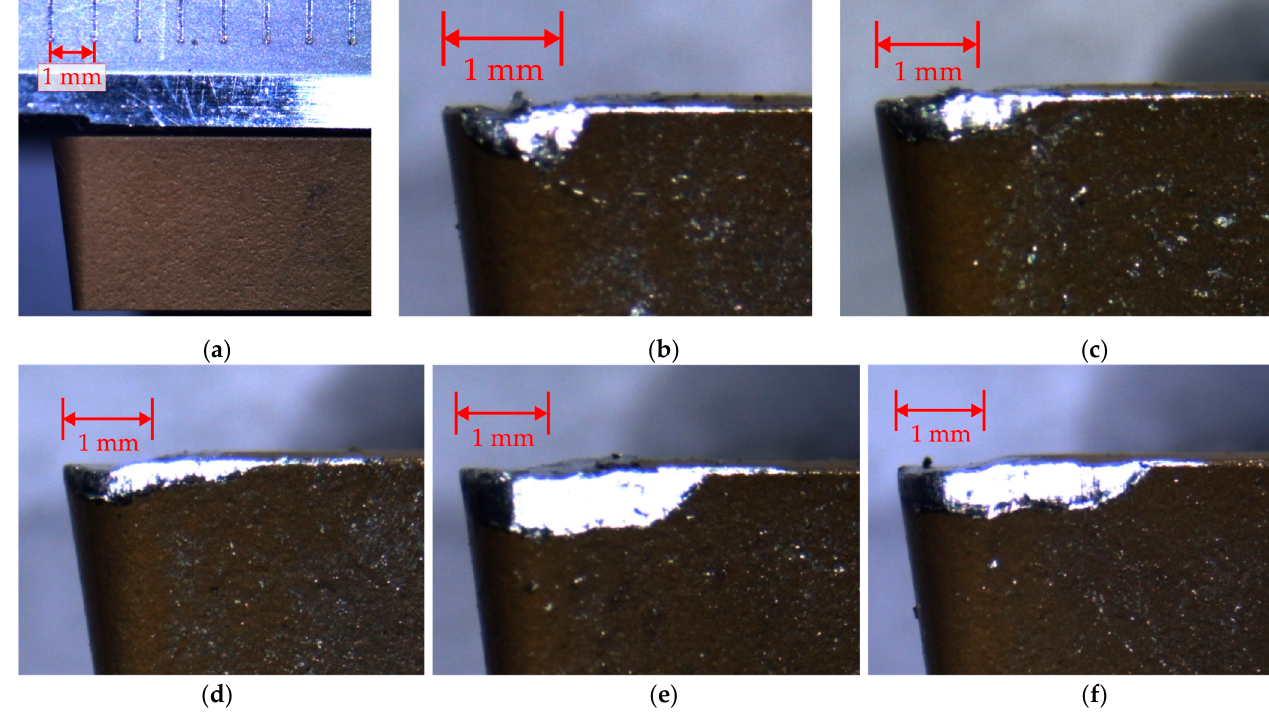
Figure 8. Cutting tools used for the cutting speed experiments: ( a ) CT-s0; ( b ) CT-s1; ( c ) CT-s2; ( d ) CT-s3; ( e ) CT-s4; ( f ) CT-s5.